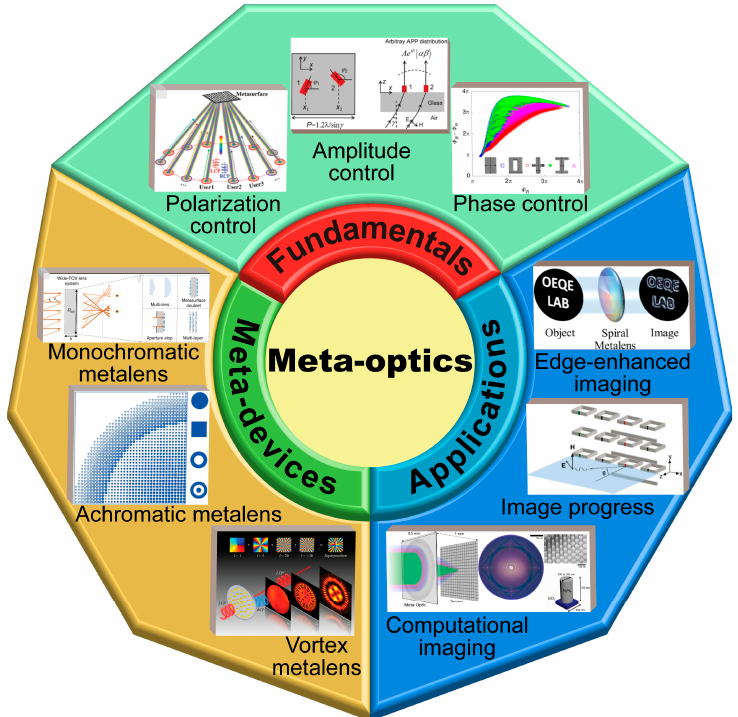
Figure 1. Fundamentals of meta-optics, meta-devices and applications. Overview of the recent development of meta-optics, including the control principle, meta-devices, and further meta-imaging [100,147–154].